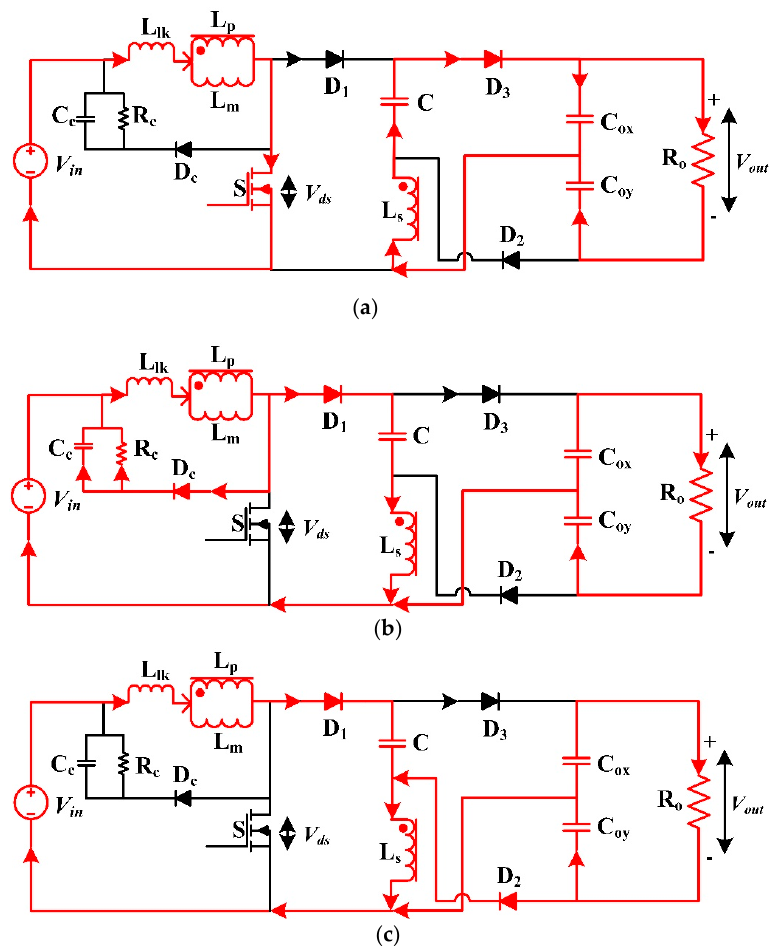
Figure 3. Modes of operation; ( a ) Mode-1, ( b ) Mode-2, ( c ) Mode-3.